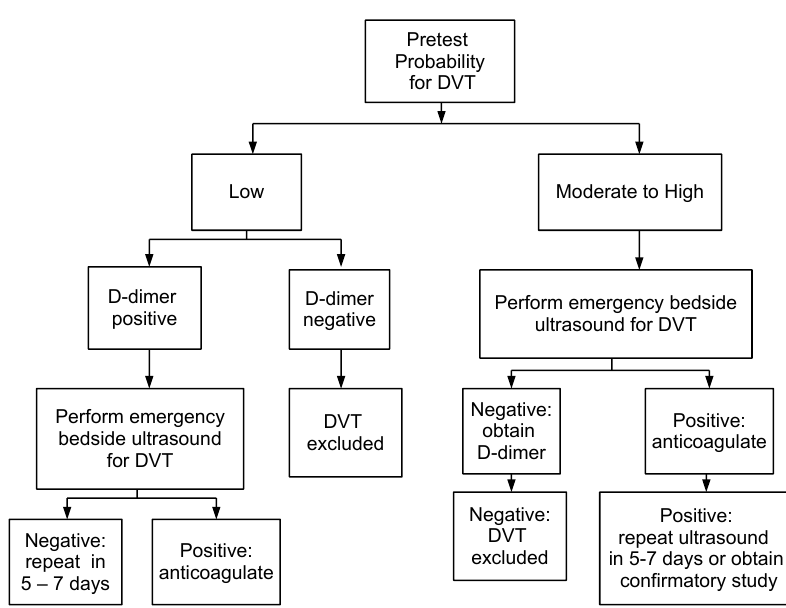
Figure 1. Protocol for the diagnosis of DVT, taken from